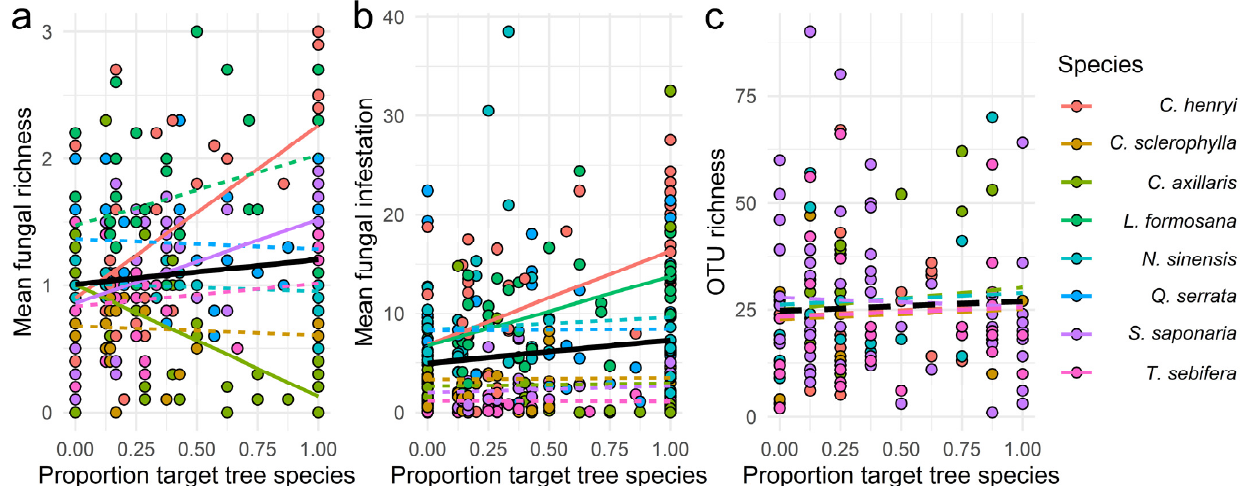
Figure 3. Effects of the host tree species proportion in the local neighbourhood on ( a ) mean fungal richness and ( b ) mean fungal infestation, both based on visual assessment, and ( c) on OTU richness. The overall regression line (in black) was obtained from a mixed model with Shannon diversity as the fixed factor and species identity and neighbourhood composition as random factors ( a ) p = 0.0138, ( b ) p = 0.0154, ( c ) p = 0.2875. The species-specific regression lines (in colour) were obtained from a mixed model with Shannon diversity and species identity as the fixed factors and neighbourhood composition as random factor. Regression solid and dashed lines represent significant and non-significant effects respectively, according to a non-overlap of the confidence intervals of the unbiased predictors for the slopes with zero.